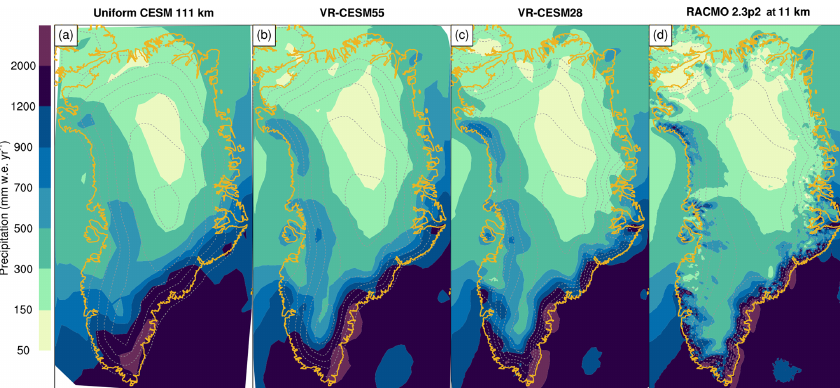
Figure 4. Spatial distribution of mean annual precipitation over Greenland. CESM data are displayed at the native CAM resolution for the period 1980–1999. RACMO2 data are shown at native 11km resolution for the same period. Coastlines and 500m elevation contours are overlain in orange and grey, respectively. Note the non-linear colour